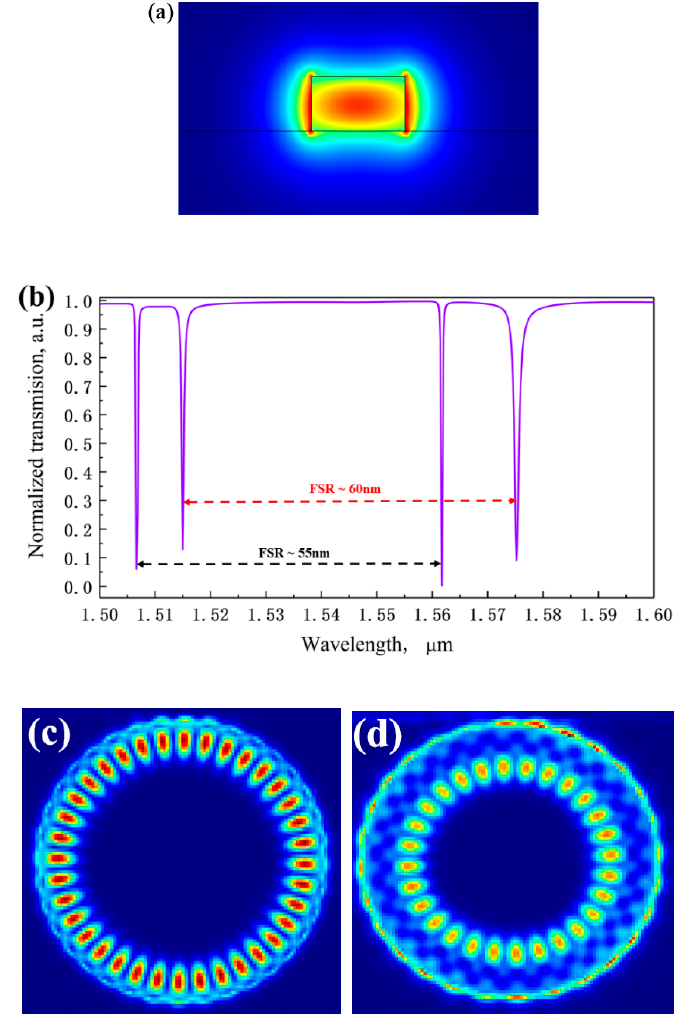
Figure 2. ( a ) The input TE mode’s energy distribution ( b ) The transmission spectrum of MDR with a particular wavelength band from 1.5 to 1.6 µ m. The electric field distribution of the first order WGM ( c ) and the second order WGM ( d ).